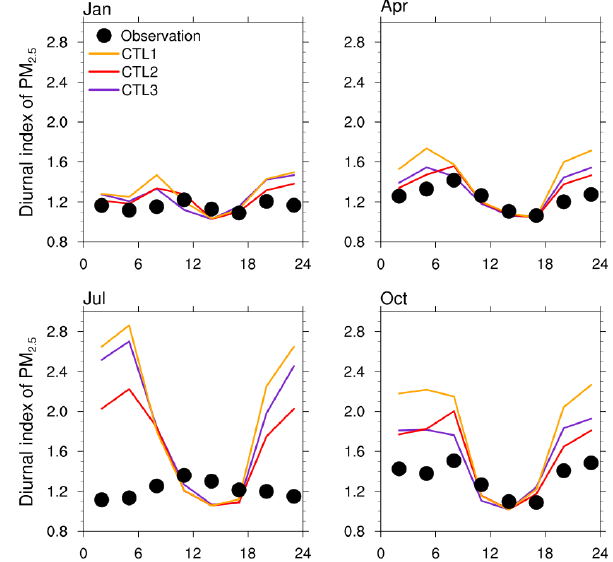
Figure 2. Diurnal index of surface PM 2 . 5 concentrations within 24h averaged over the YRD region of East China (within the black box of Fig. 1a) for January, April, July, and October of 2018 from experiments CTL1, CTL2, and CTL3, and observations. Both the simulated results and observations are sampled at the model output frequency, i.e.,